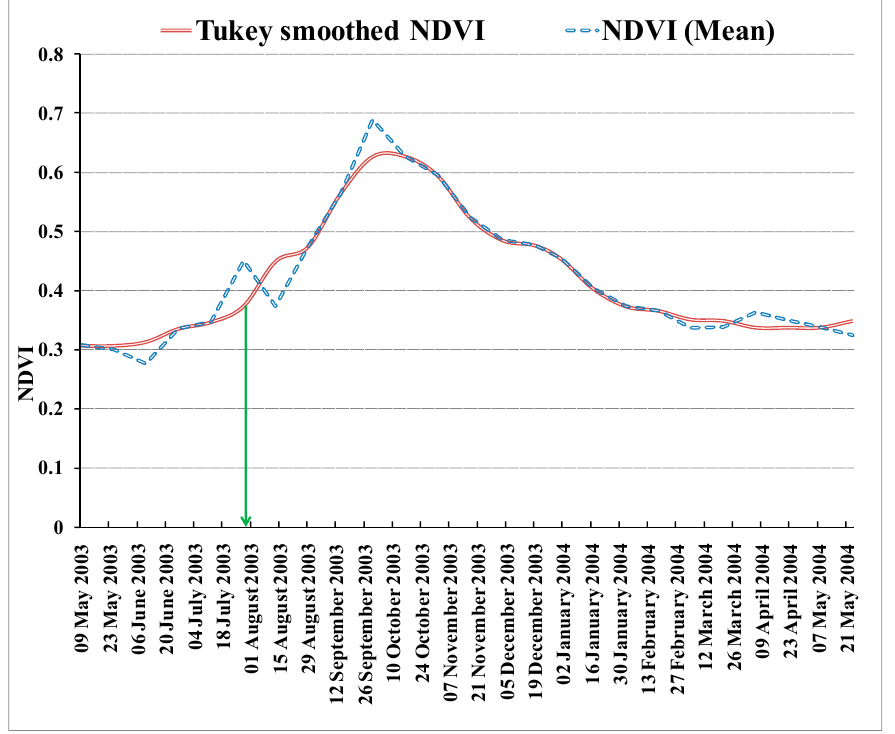
Figure 6. Raw MODIS NDVI and TS-smoothed reconstructed NDVI time series of year 2003–2004 for derivation of start of the season in Tectona grandis indicated by green arrow.